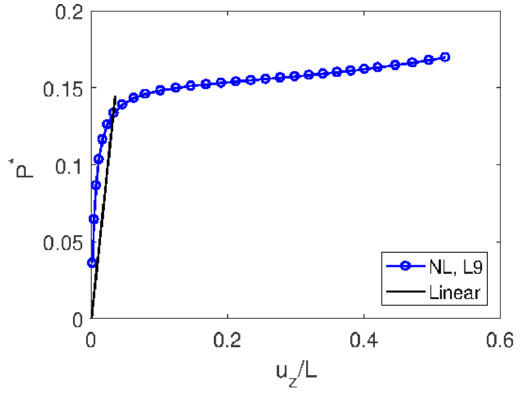
Figure 17. The equilibrium curves for L9 of two-cell composite beam subjected to axial loading, P ∗ = 4 PL 2 / π 2 EI .